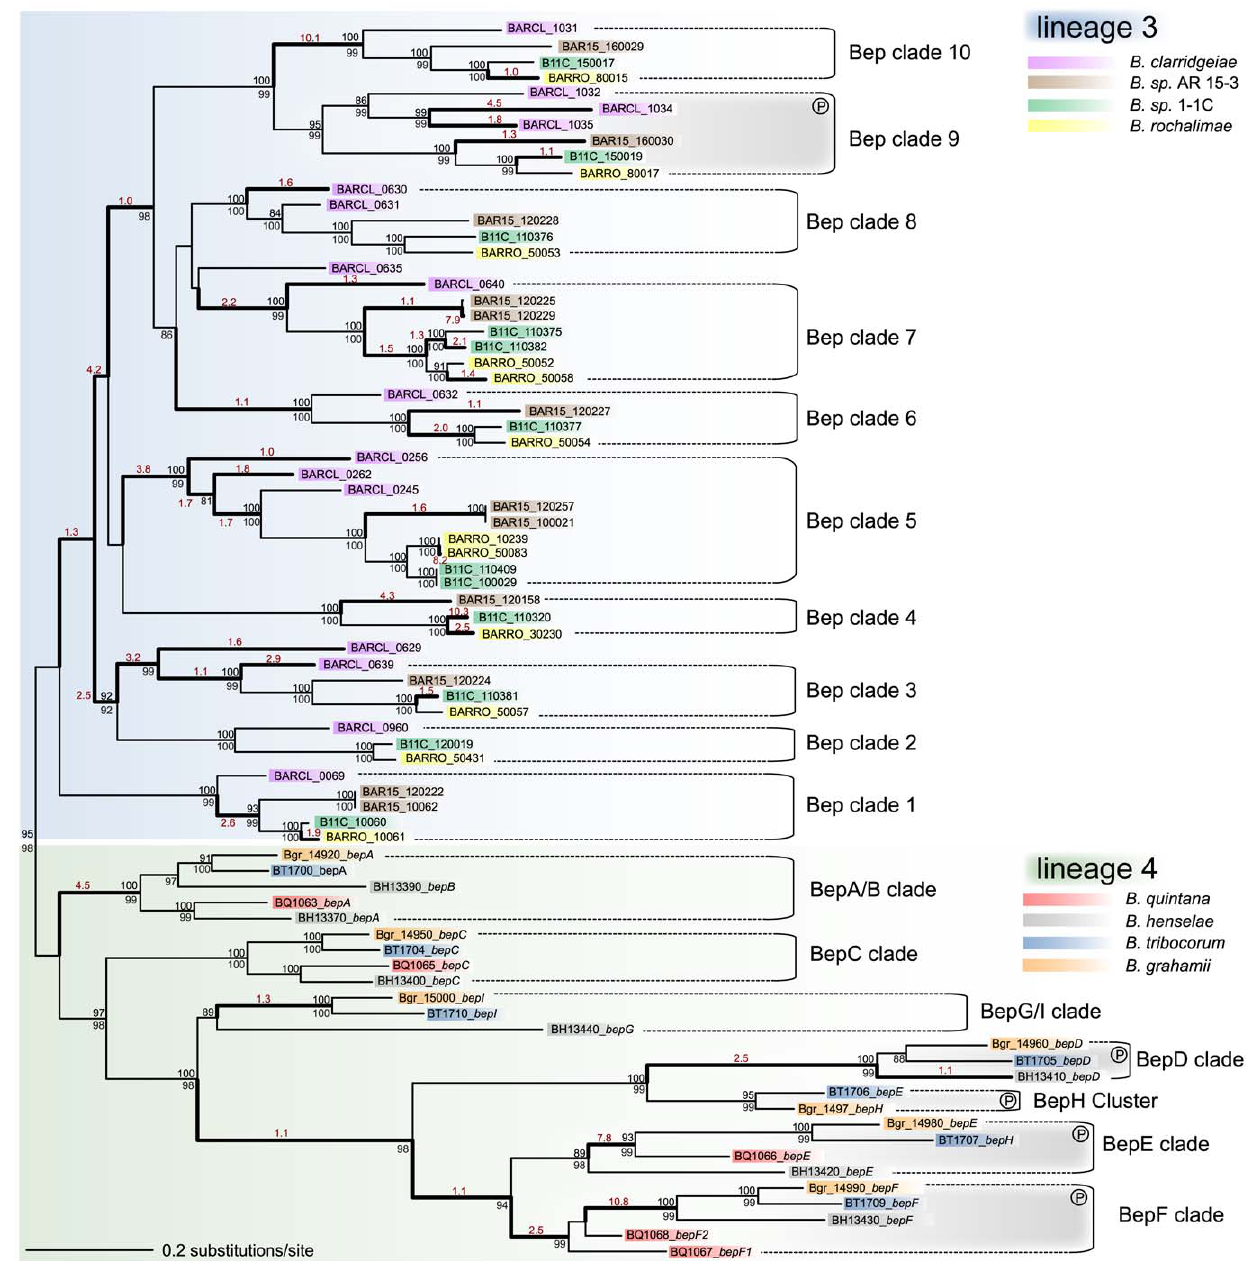
Figure 4. Gene tree of Bartonella effector proteins. The maximum likelihood tree is based on the BID domain and the C-terminal extension of all bep genes. Numbers above the branches represent maximum likelihood bootstraps (100 replicates); numbers below Bayesian posterior probabilities. Values $ 80% are shown. The independent clustering of the bep genes from lineage 3 and lineage 4 is indicated by blue and green shading, respectively. Different bep genes are named with locus_tag and gene name (if existing) and they are color-coded species-specifically according to the legend. Bold type highlights phylogenetic branches with d n/ d s values . 1 (the estimated d n/ d s value is indicated in red color type). Sub-clades comprising orthologous bep genes are indicated (Bep clades). In lineage 3, BARCL_0629 and BARCL_0635 are not included in any clade since their phylogenetic position is neither supported by bootstraps nor posterior probabilities. In both lineages, clades of bep genes encoding tandem- repeated tyrosine-phosphorylation motifs are indicated by gray shading and an encircled ‘P’